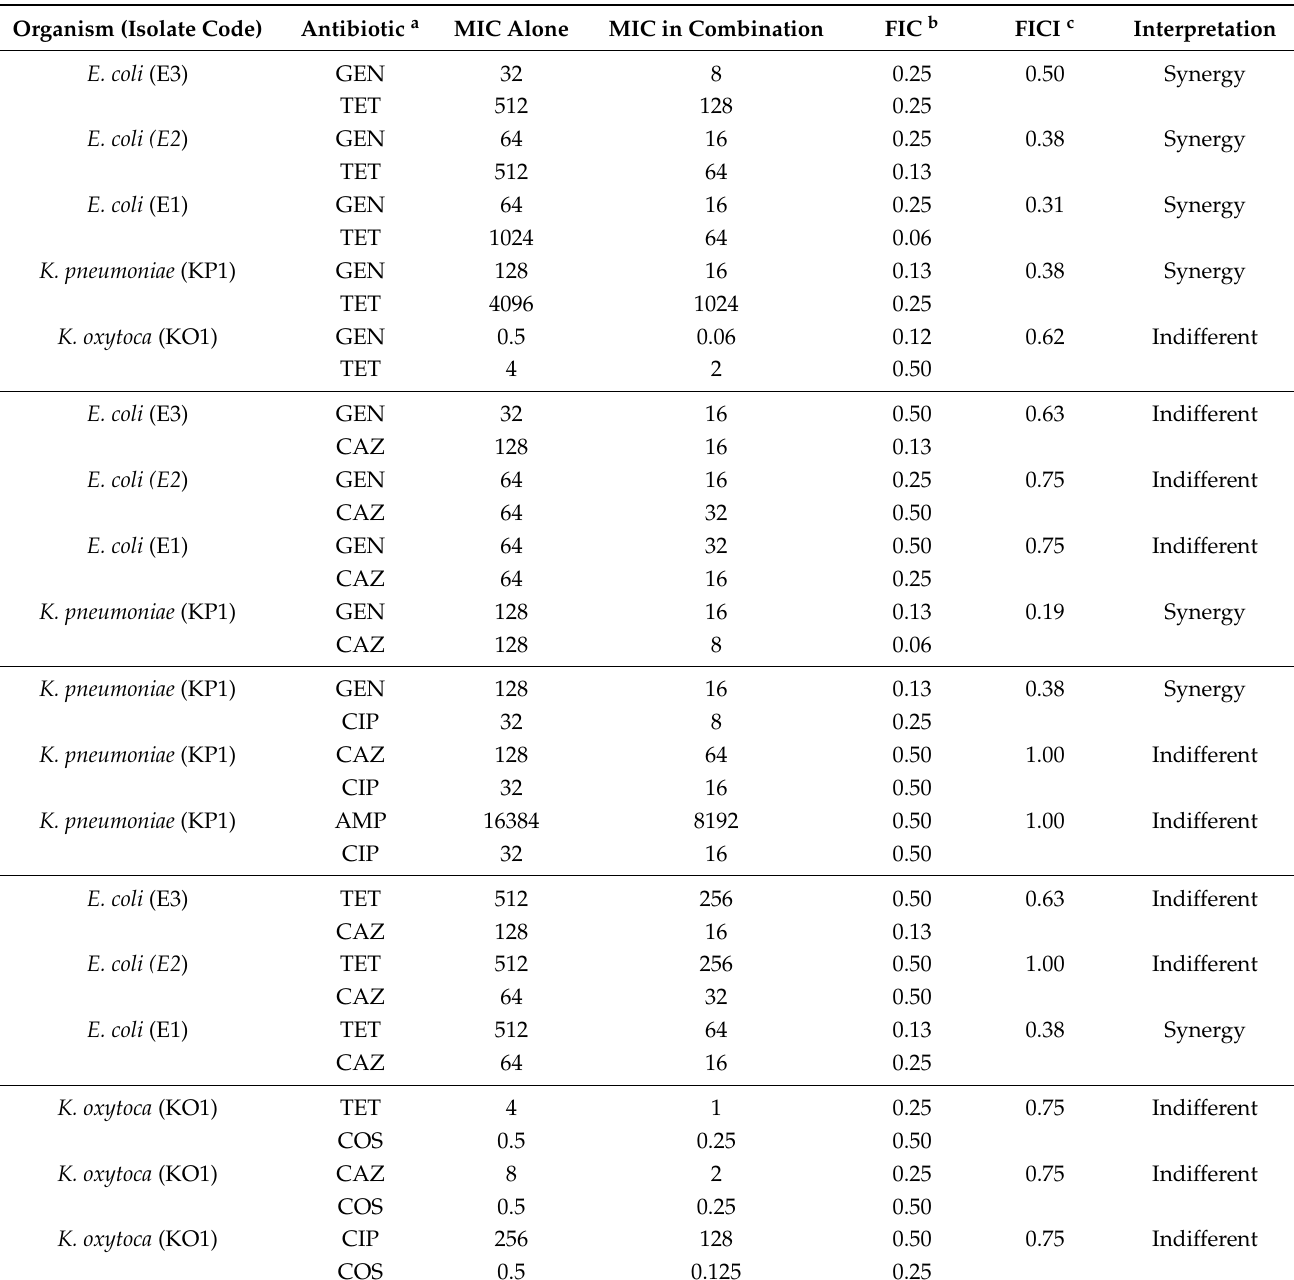
Table 3. The minimum inhibitory concentration (MIC) of antibiotics singly and in combina- tion as derived from the checkerboard assays for multidrug-resistant integron-harbouring E. coli , K. pneumoniae, and K. oxytoca